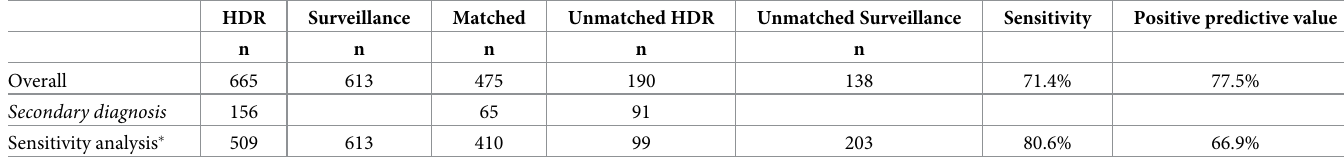
Table 3. Summary of the capture-recapture analysis and the calculated indicators (i.e. sensitivity and positive predictive